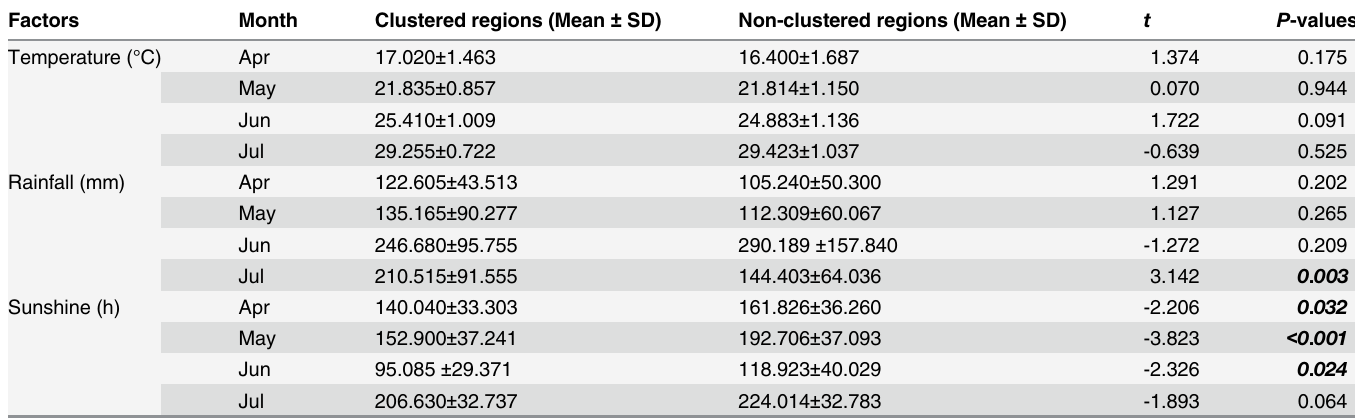
Table 6. The comparison of meteorological factors between clustered regions and non-clustered regions during the peak period (April to